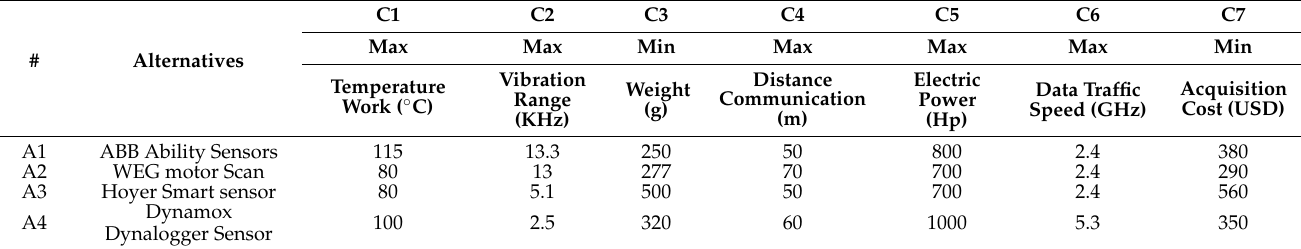
Table 6. Matrix of